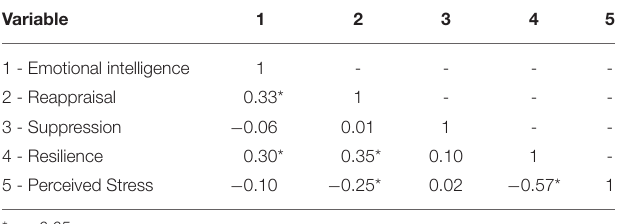
TABLE 1 | Correlation coefficients for emotional intelligence, reappraisal, suppression, resilience, and perceived stress. Variable